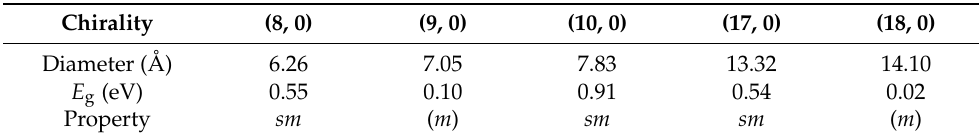
Table 1. Chiralities, diameters, the calculated electronic bandgap ( E g ) and the electrical properties of selected SWCNTs.